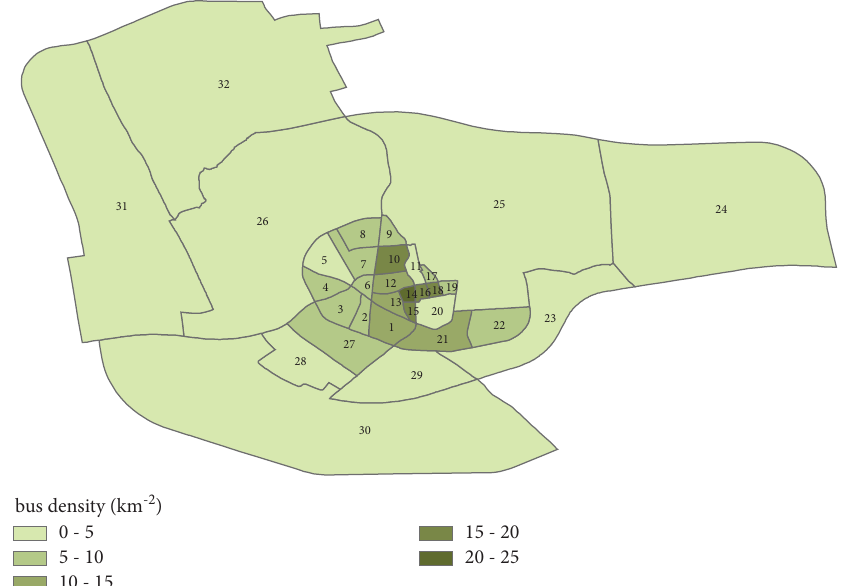
Figure 9: Spatial distributions of bus stop density in Xuancheng,